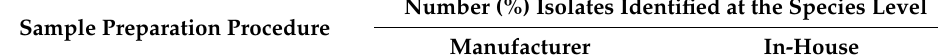
Table 5. Isolates identified at the genus level and included in the Filamentous Fungi Library